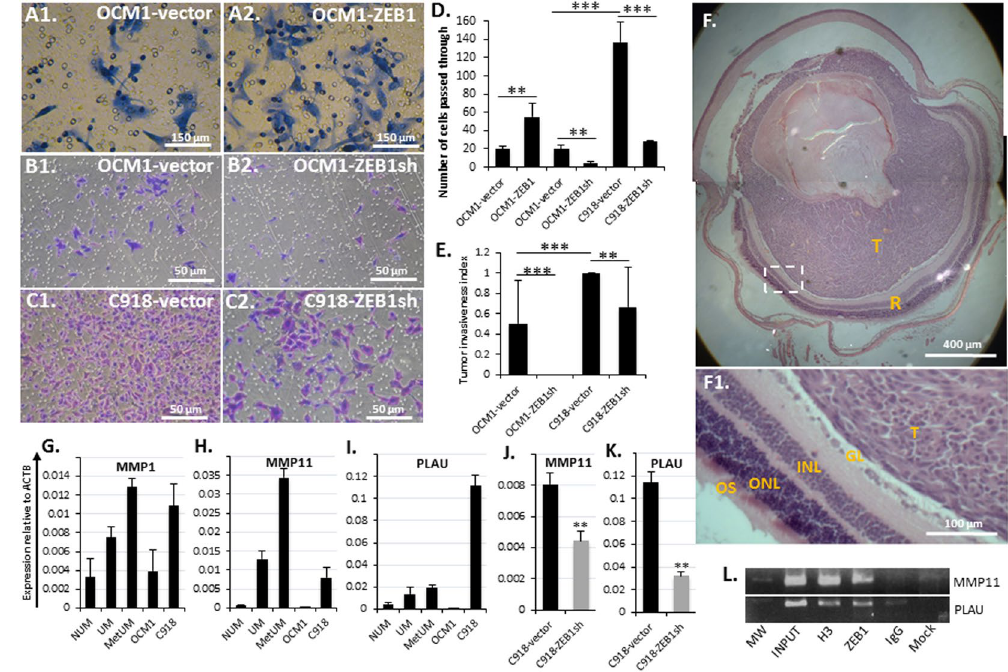
Figure 7. ZEB1 promotes UM cell invasiveness. Cells passed through the transwell membranes were formaldehyde fixed, crystal violet stained. ( A ) Representative images of the penetrated OCM1-vector control cells and ZEB1 overexpressed OCM1 cells (OCM1-ZEB1). ( B ) Representative images of the penetrated OCM1-vector control cells and ZEB1-knockdown OCM1 (OCM1-ZEB1sh). ( C ) Representative images of the penetrated C918-vector control cells and ZEB1-knockdown C918 (C918-ZEB1sh). ( D ) The number of the penetrated cells affected by ZEB1 overexpression or downregulation were counted in 4 randomly selected microscopic fields at day 2 after equal number cell seeding and a mitomycin C treatment. ( E ) Equal number of OCM1- and C918-vector controls and ZEB1sh knockdown cells (2 × 10 5 ) were intravitreously injected into the nude mice and their 25-day grafted ocular tumors were examined for tumor invasiveness evaluation. ( F ) A representative H&E stained section of the OCM1-ZEB1sh cell-derived tumor in the grafted vitreous, showing that the tumor (T) was not invasive to the surrounding retina (R) including the ganglion layer (GL), inner nuclear layer (INL), outer nuclear layer (ONL), and the outer segment (OS). Transcriptional analyses of ( G ) matrix matelloproteinases MMP1 , ( H ) MMP11 , and ( I ) another matrix degradation proteinase PLAU . Knockdown of ZEB1 reduced both ( J ) MMP11 and ( K ) PLAU expression in C918. ( L ) ChIP assays showed that ZEB1 bound to the MMP11 and PLAU gene promoters. Mean (M) ± standard deviation (SD). Student’s t-tests were performed. ** Indicates p ≤ 0.01; *** Indicates p ≤